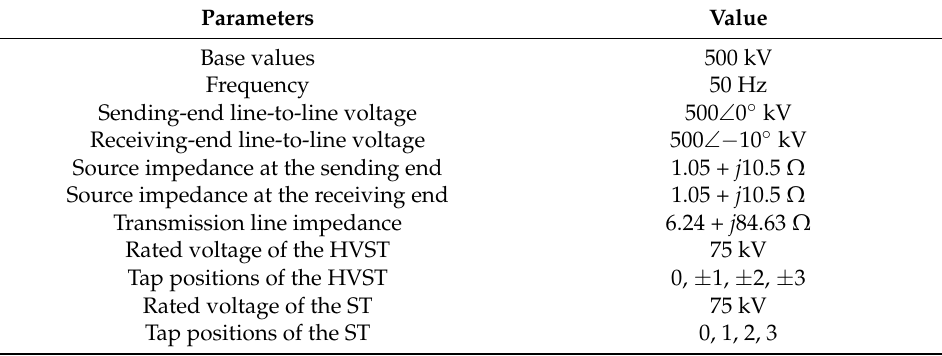
Table 2. Simulation parameters for the ST and the HVST.